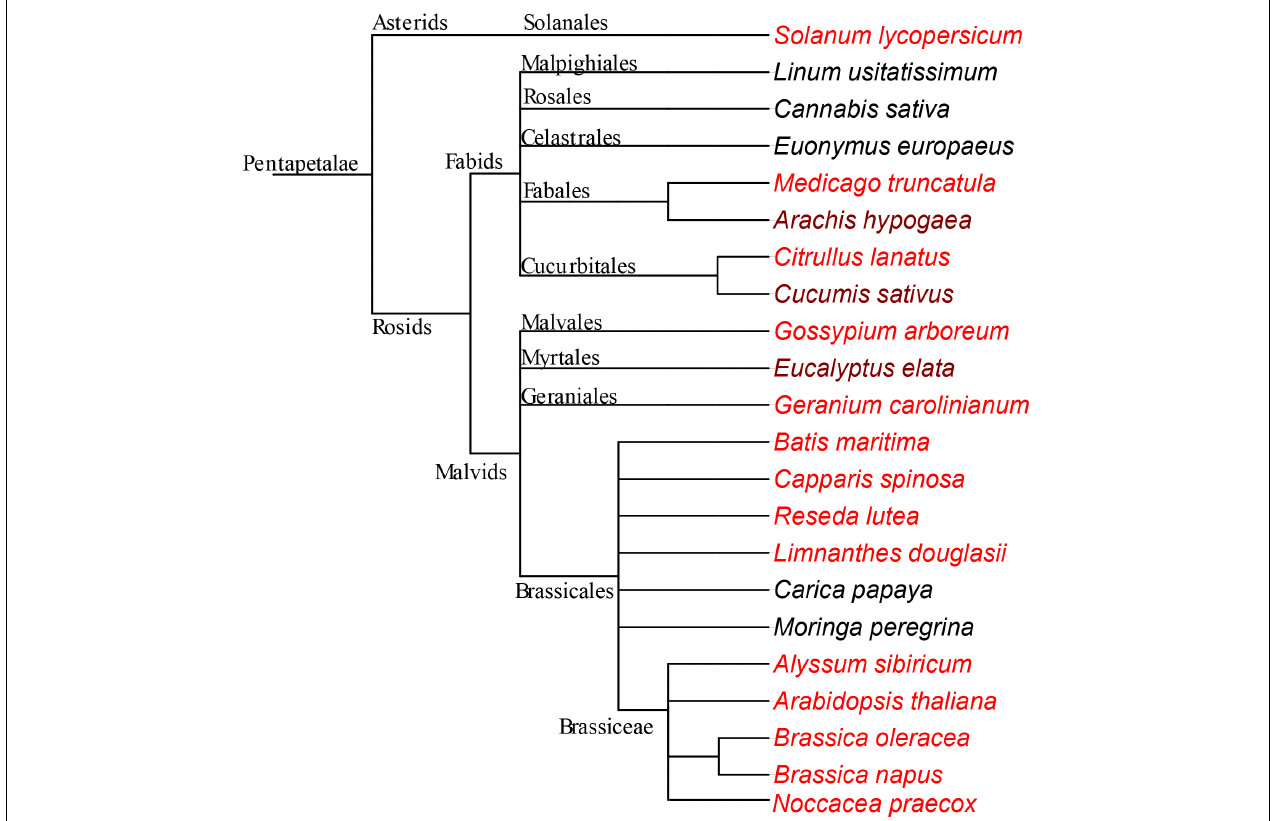
FIGURE 8 | Fe-enriched endodermis is a conserved feature in Rosids. Schema representing species that are used in this study. The phylogenetic tree was generated using NCBI taxonomy database and exported with the version 3 of the Interactive Tree of Life (iTOL) (Letunic and Bork, 2016). Both dark and light red colored species were enriched with Fe around provascular strands. In the darker-red-colored species, endodermis Fe does not represent the highest concentration of Fe, in contrast to the lighter-red-colored species. The species which are not red, do not specifically accumulate large Fe reserves in their endodermis. See discussion for the interpretation of the negative